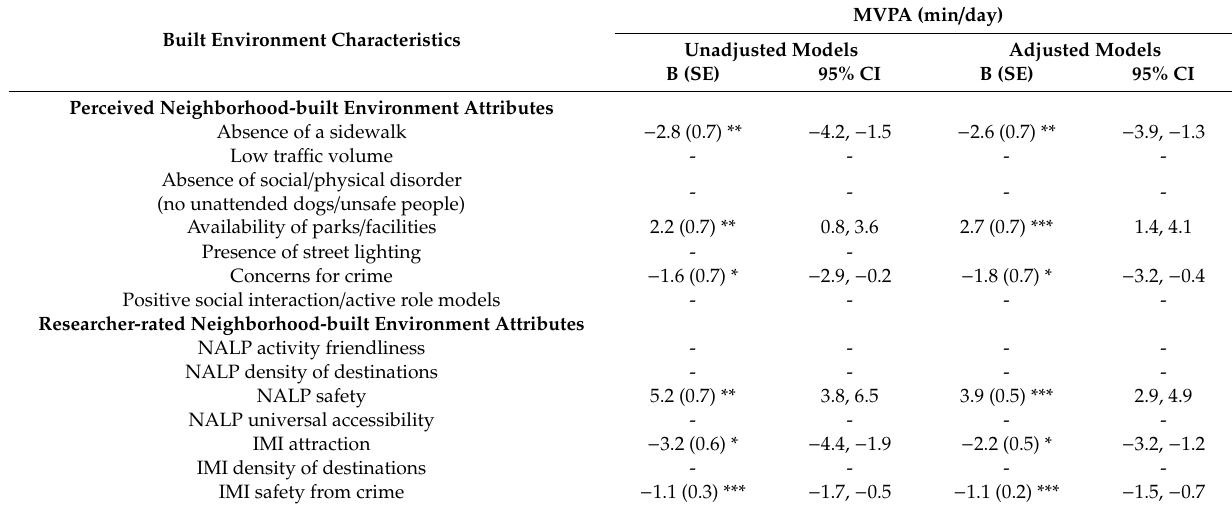
Table 2. Associations between BE characteristics and average daily minutes of MVPA (only significant associations from the final model